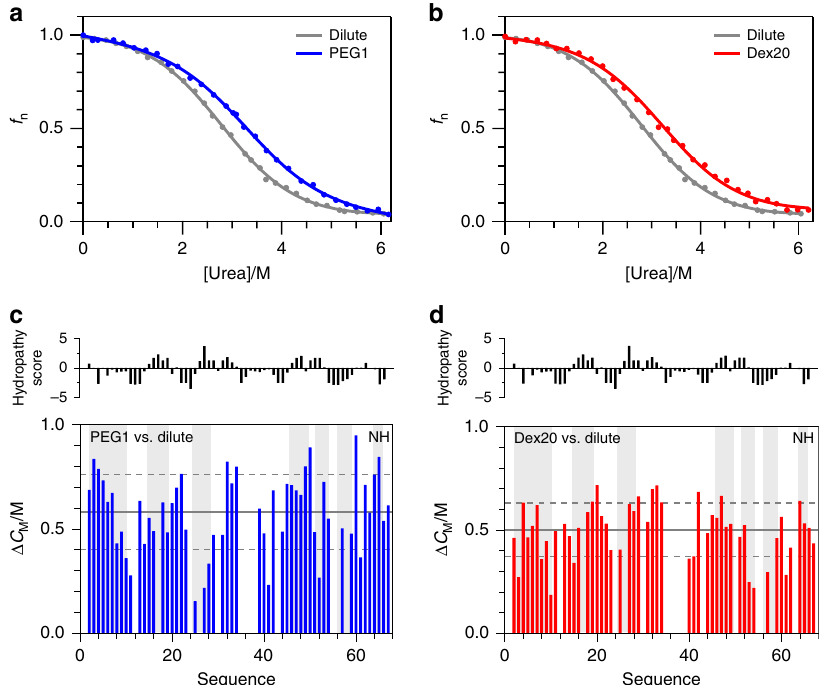
Fig. 2 Thermodynamic stability of Bs CspB monitored via following folding-to-unfolding transitions induced by urea. a , b Analysis of aliphatic protons representing the native state, f n , observed by one-dimensional 1 H NMR spectroscopy in absence of MC (colored in gray), in presence of c = 120 g/L PEG1 (colored in blue, a ), and c = 120 g/L Dex20 (colored in red, b ). c , d Difference in the transition midpoint, Δ C M , of amide protons observed in two- dimensional 1 H- 15 N HSQC NMR spectra comparing dilute conditions with the presence of c = 120 g/L PEG1 (colored in blue, c ) or c = 120 g/L Dex20 (colored in red, d ). Beta sheet regions according to PDB ID 1NMG are indicated by using a background colored in gray. The average of Δ C M is shown by the horizontal line (continuous mode) whereas the mean plus or minus one standard deviation of Δ C M is represented by two additional horizontal lines (dotted mode). The hydropathy score 76 concerning Bs CspB has been shown on top by using the online tool ProtScale available at the Bioinformatics Resource Portal ExPASy 77